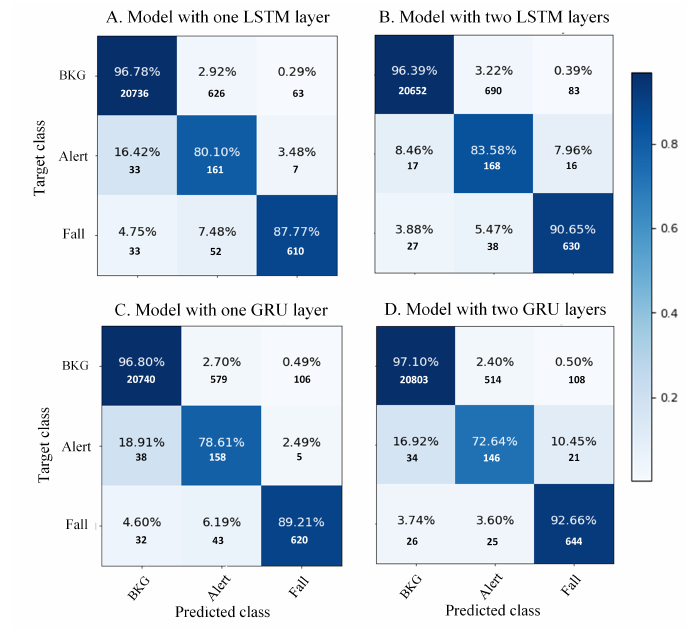
Figure 6. Confusion matrix of the best models for each architecture considered (at 25